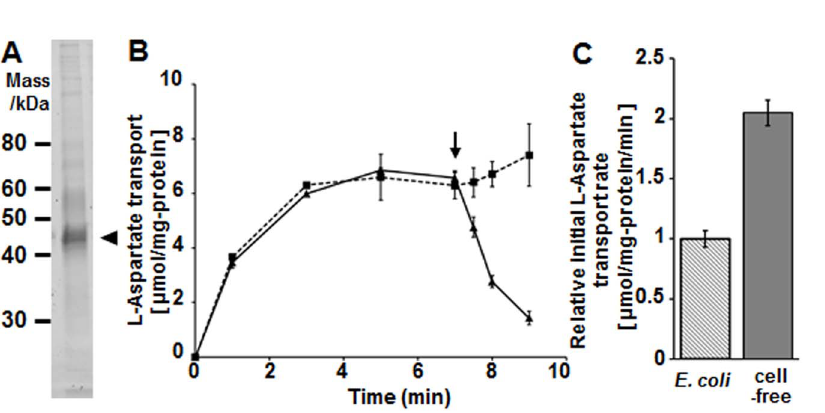
Fig. 4. Reconstitution of the AspT aspartate transporter synthesized in the cell-free system with Sf21 microsomes. (A) Cell-free synthesized AspT purified with cobalt affinity resin under non-denaturing conditions was solubilized with 1.5% DDM, and eluted with 0.01% DDM and 250 mM imidazole. The purified AspT protein (arrow head) was subjected to SDS-PAGE. (B) L-aspartate transport activity of proteoliposomes containing purified AspT protein. Proteoliposomes loaded with 100 mM L-aspartate were resuspended in 50 mM phosphate buffer (pH 7) (8.3 m g protein/ml). At 0 min, L-[ 3 H] aspartate was added into the buffer (2.5 mM final concentration). After the rate of influx and efflux of L-[ 3 H] aspartate was equal (at steady state), non-radiolabelled L-aspartate was added to a final concentration of 15 mM at 7.5 min (solid line, arrow indicating time of addition of unlabelled substrate). The broken line corresponds to the same experiment performed without addition of unlabelled L-aspartate. (C) Comparison of the initial uptake rates for L-aspartate into E. coli expressing AspT (hatched bar) and into microsomes containing cell-free synthesized AspT (solid bar). The transport activity at 1 min was regarded as the initial uptake rate.